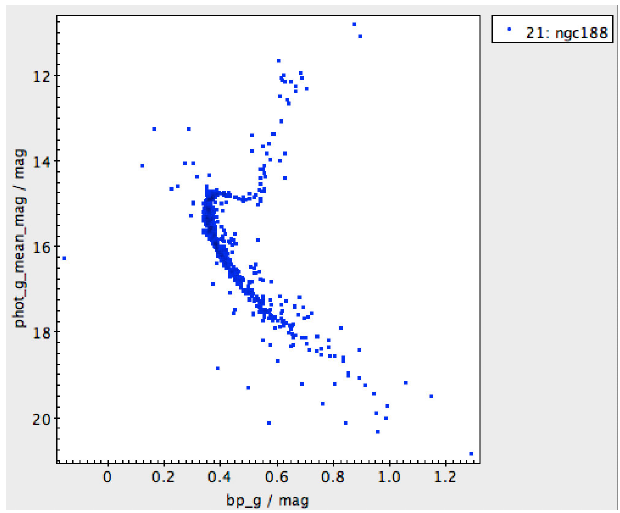
Fig. 69.— Color-magnitude diagram of NGC 188